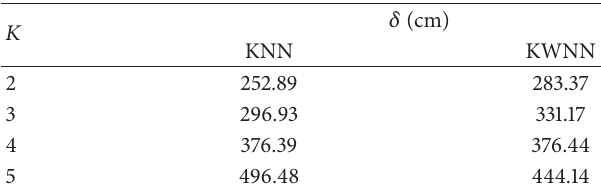
Table 2: Mean positioning error, 𝛿 , for KNN and KWNN algorithm with optimization.